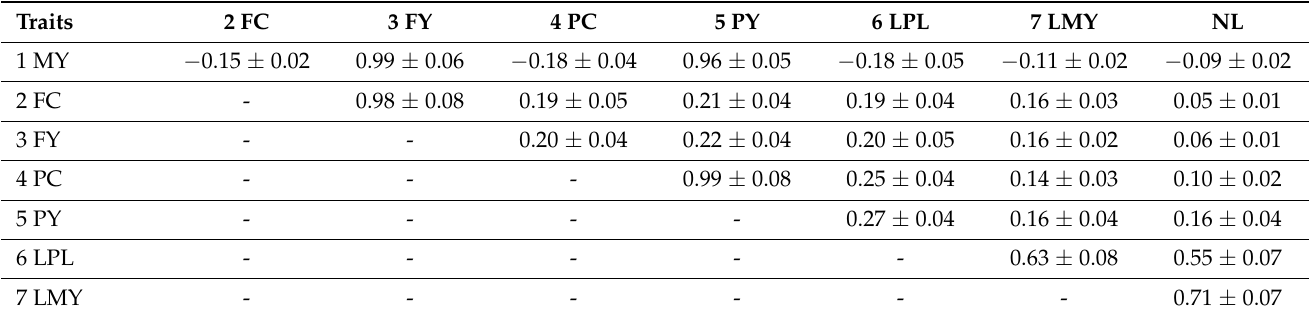
Table 5. Genetic correlations (r xy ) between the milk traits and longevity